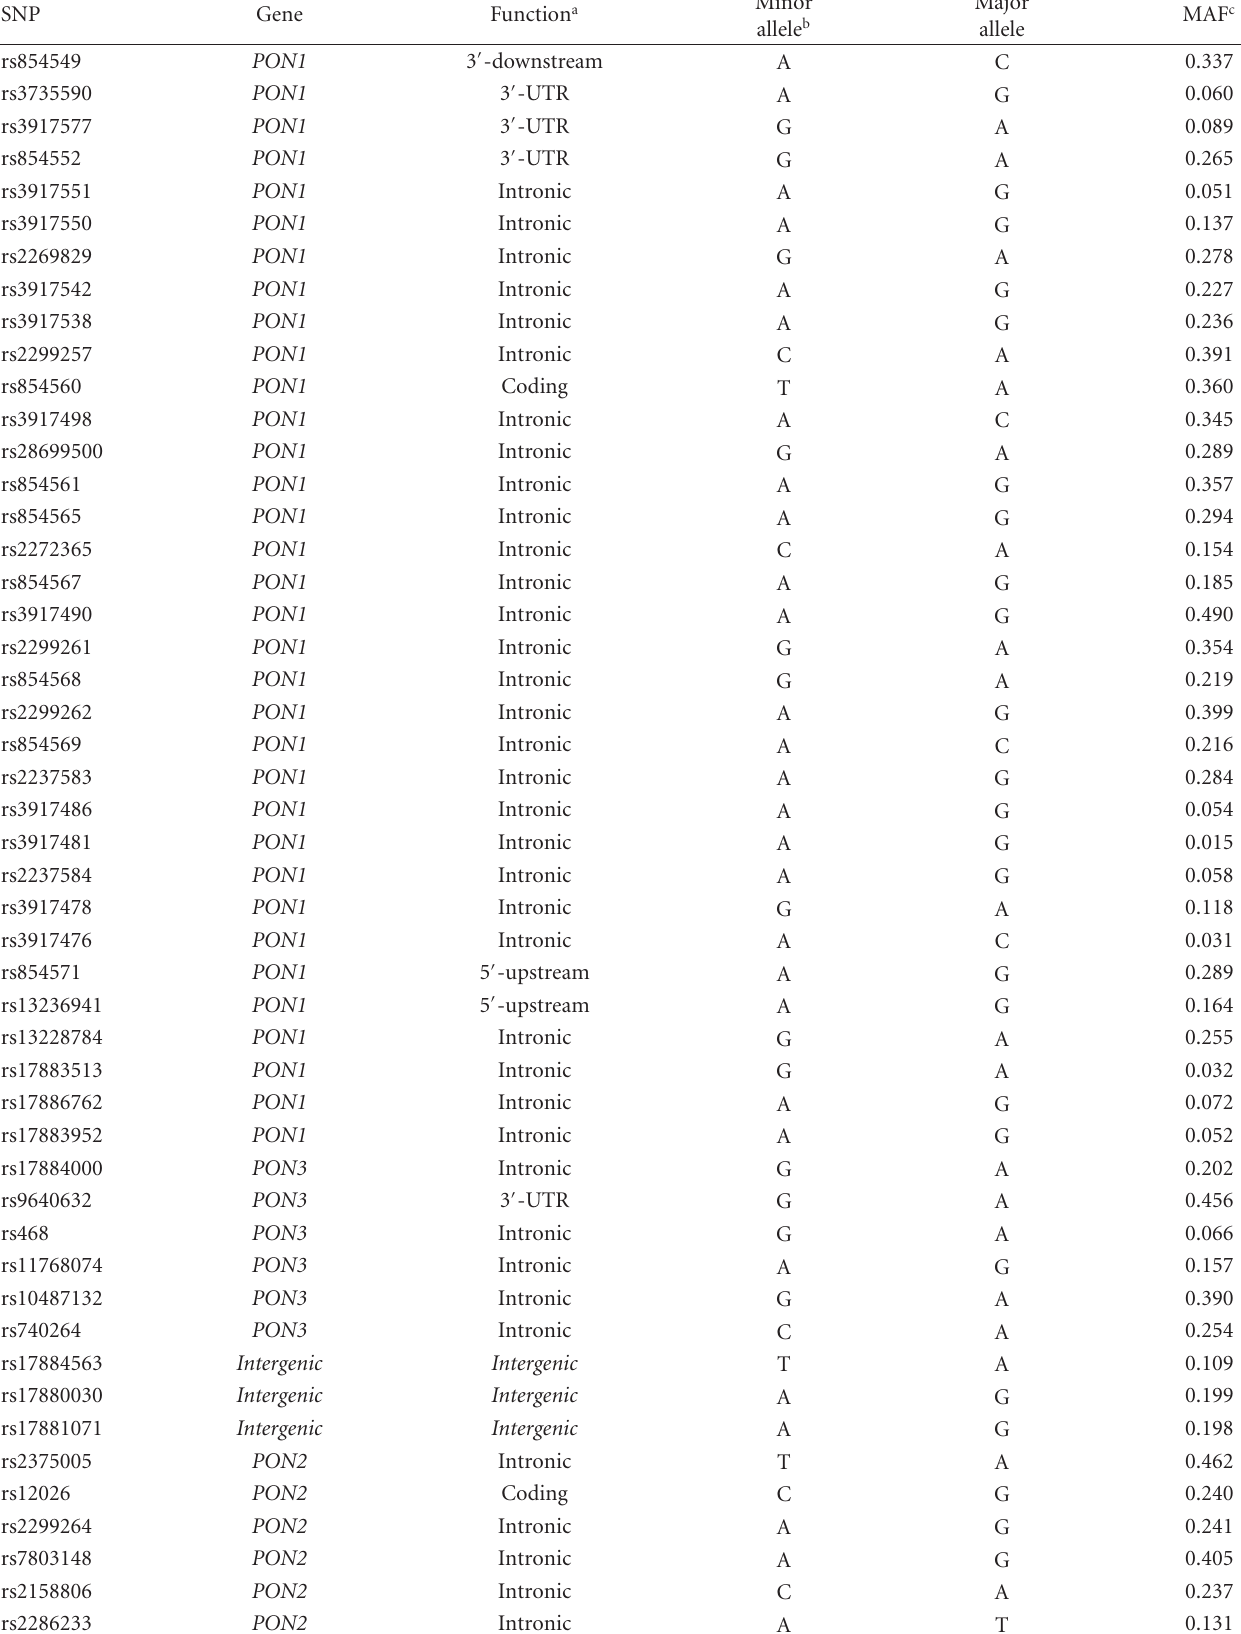
Table 1: Characteristics of the 51 SNPs studied in the PON gene